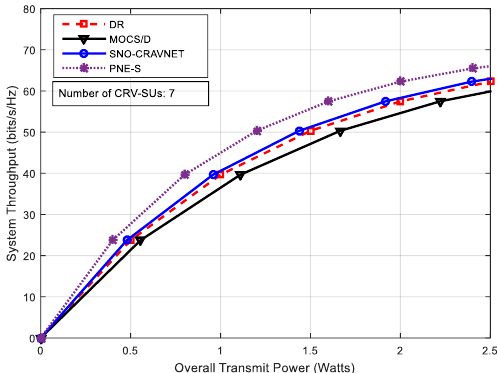
Figure 3. Performance evaluation using the achieved system throughput measured against the overall